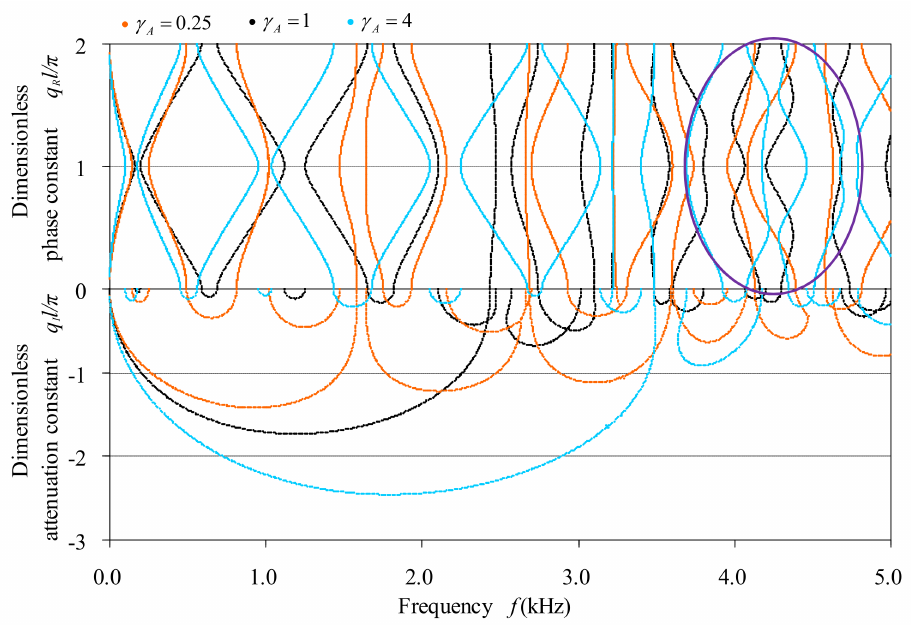
Figure 9. Effect of the cross-sectional area of constituent beam on the band structures of the bi-coupled periodic beam with Ternary-I unit cell.